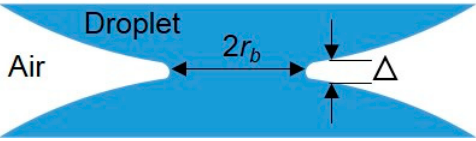
Figure 3. The close-up of the small bridge (or neck) connecting two droplets. 2 r b is the diameter of the bridge along the initial contact line and ∆ is the bridge width.